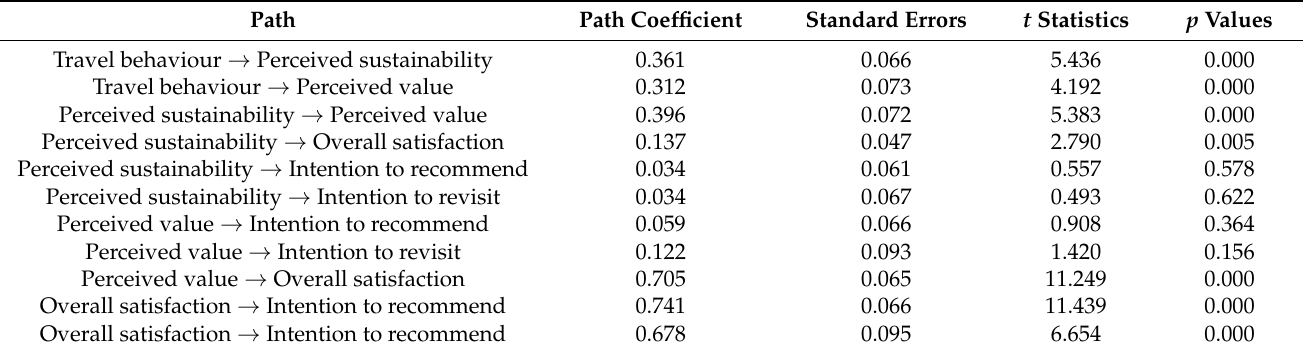
Table 2. Structural Model